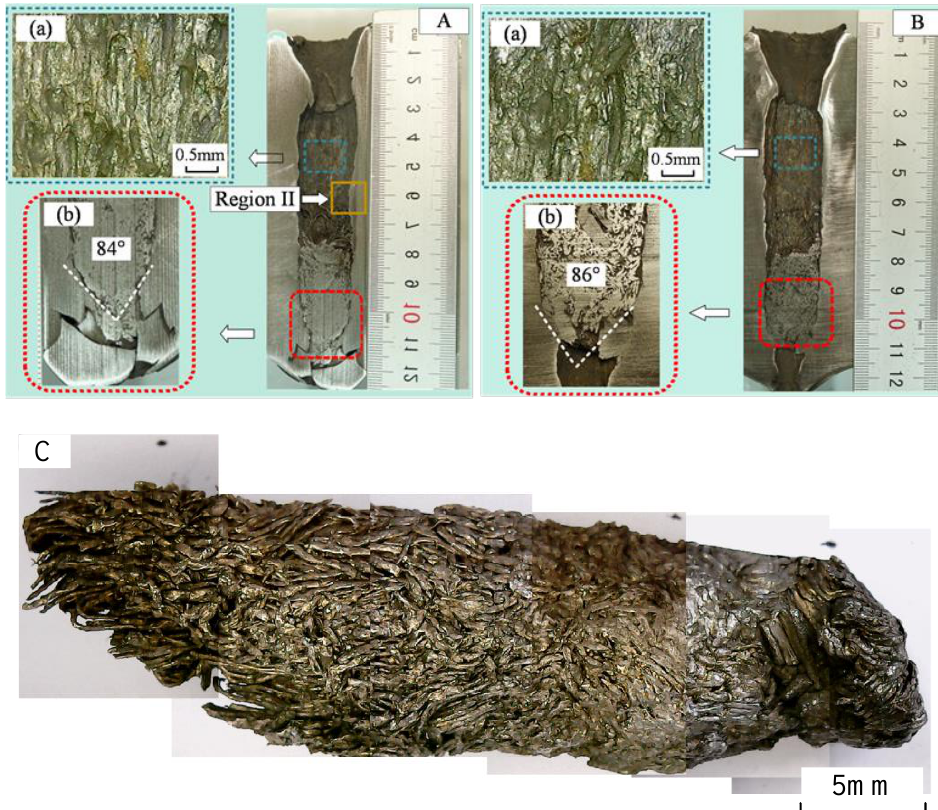
Figure 5. Longitudinal sections of craters penetrated by Wf/Zr-MG rods, ( A ) penetrator of 2#, ( B ) penetrator of 3#, and ( C ) residue of 2# rods; (a) partial enlarged drawing of craters; (b) head angles of the rods.